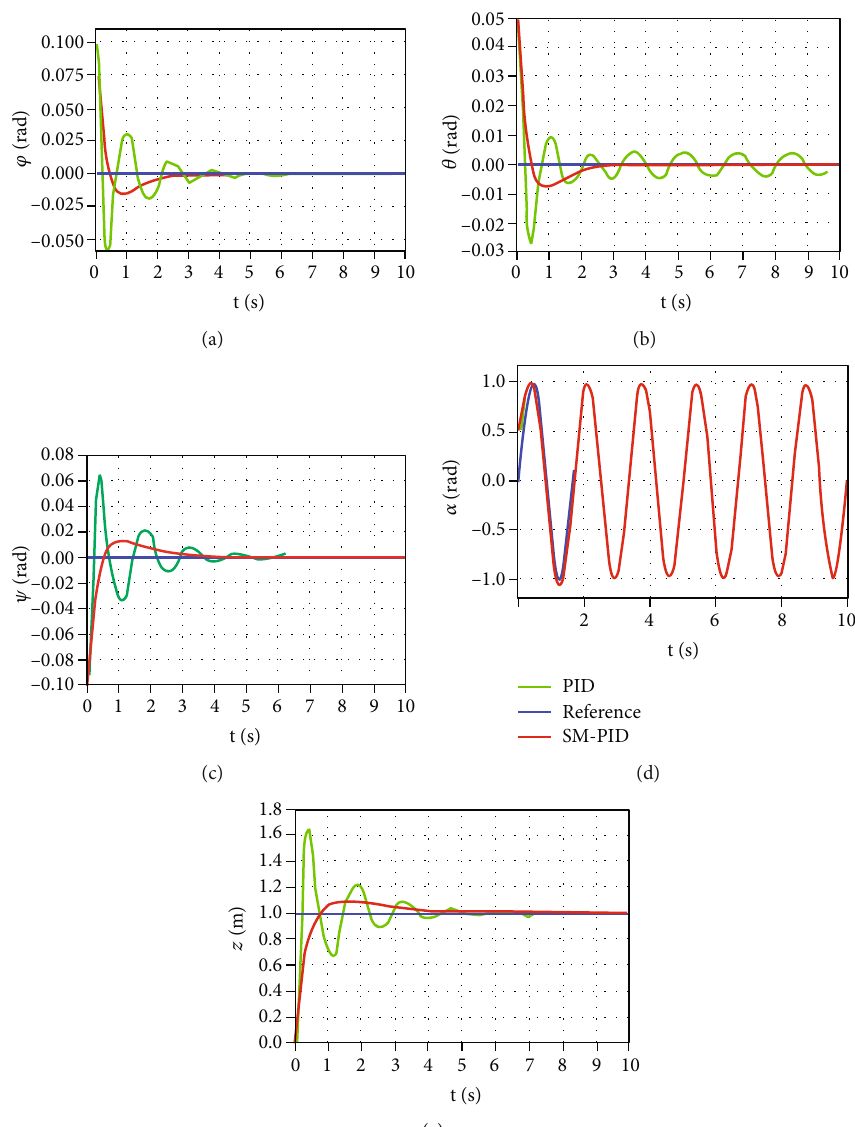
Figure 11: Attitude curves under two types of control under sinusoidal motion. (a) Rolling angle. (b) Pitch angle. (c) Yaw angle. (d) Pull down tilt angle. (e) Altitude